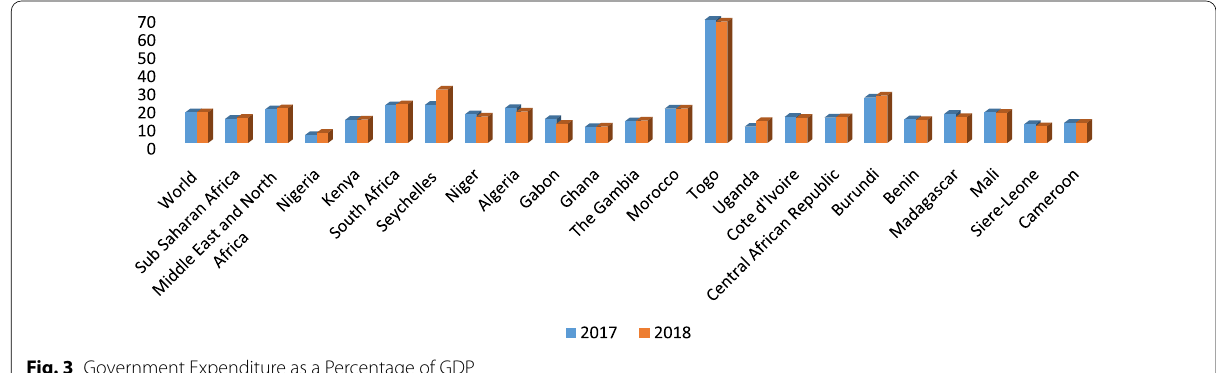
Fig. 3 Government Expenditure as a Percentage of